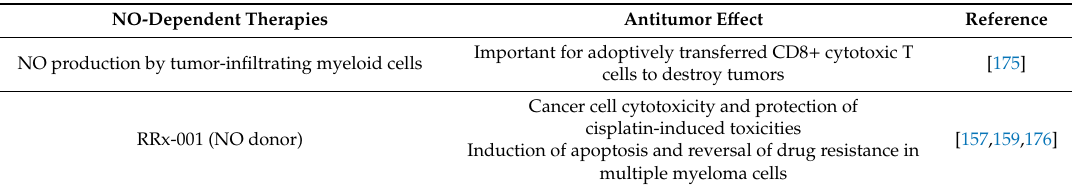
Table 3. NO-based therapies for various cancers and their e ff